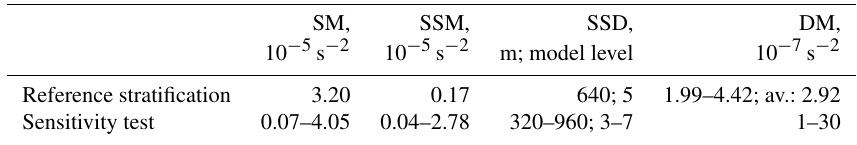
Table 2. Parameters of the reference stratification profile and corresponding ranges of change in the sensitivity test (SM: surface magnitude, SSM: subsurface magnitude, SSD: subsurface depth, DM: deep magnitude). For the case of DM, the average (av.) is given in addition to the range of values in the profile section.